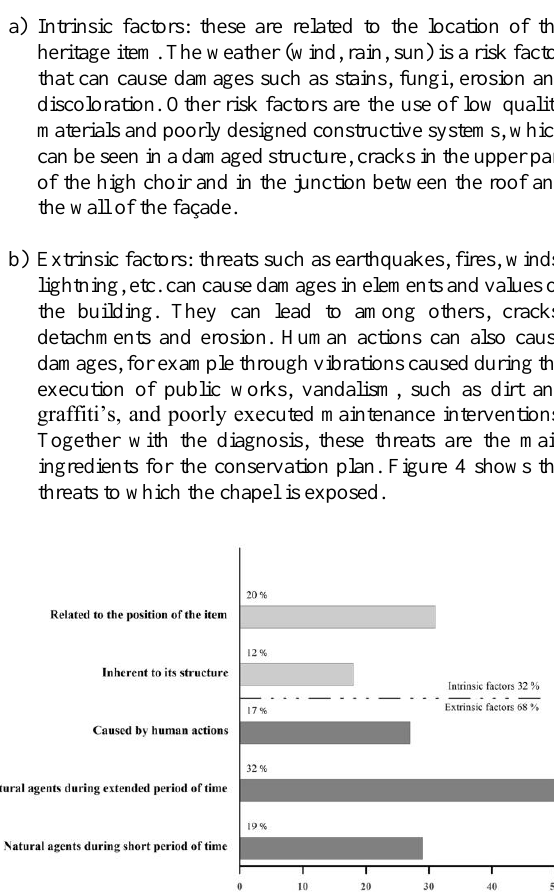
Figure 4. Threats to which the chapel of Susudel is